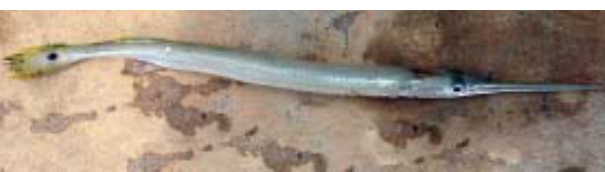
Image 12. Malabar Loach Lepidocephalus thermalis